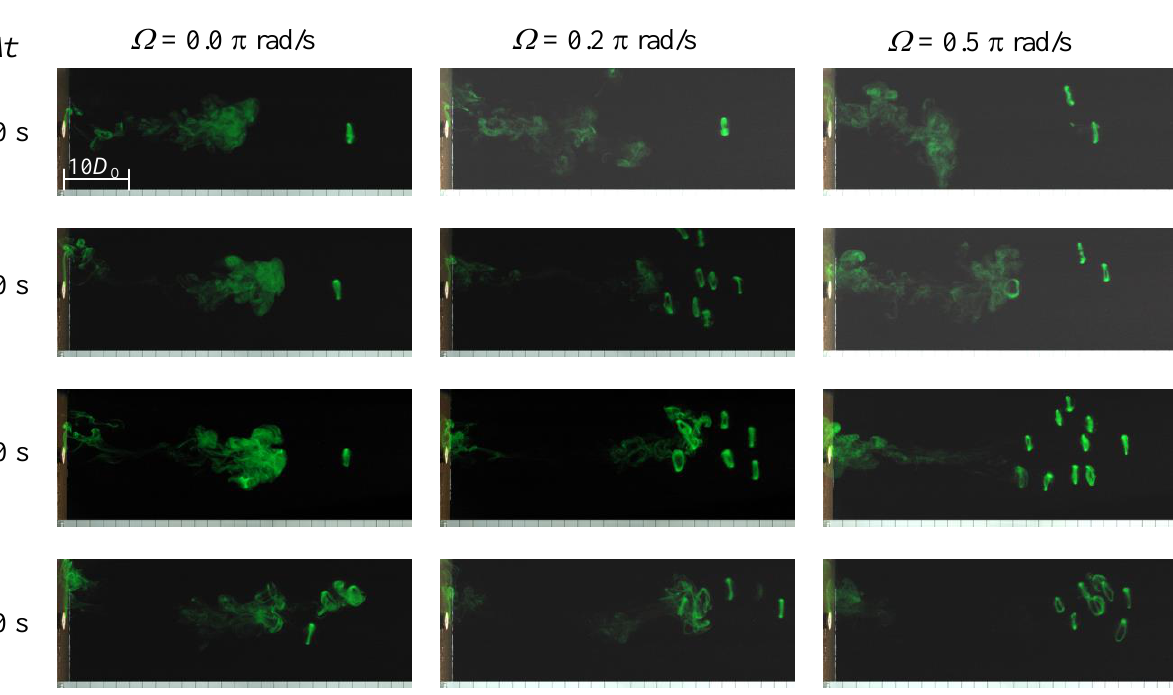
Fig. 7 Fluid distribution transported by vortex rings with/without swirl at t * = 45 s in cases